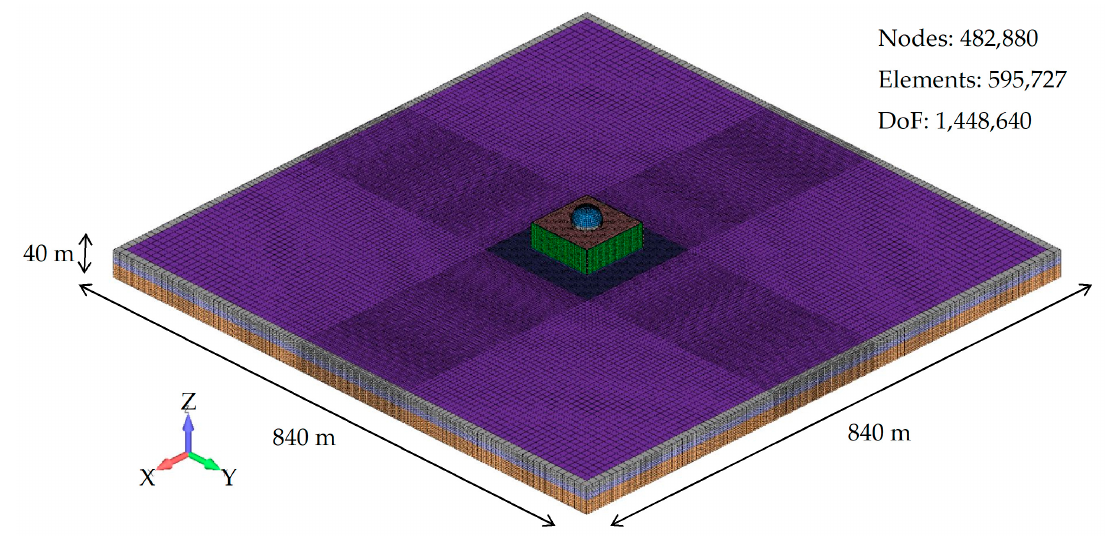
Figure 8. The high-fidelity analysis model for evaluating the effect of dynamic interactions between a reactor building and soil under an earthquake.